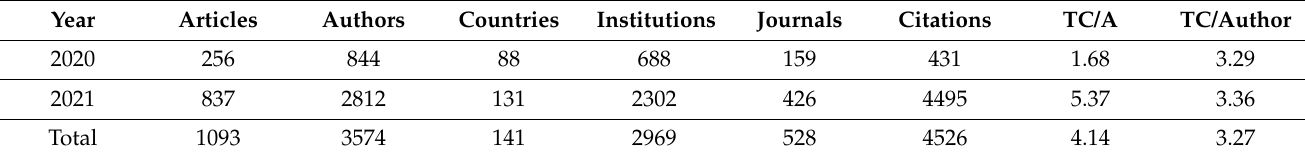
Table 2. General characteristics of the scientific production.